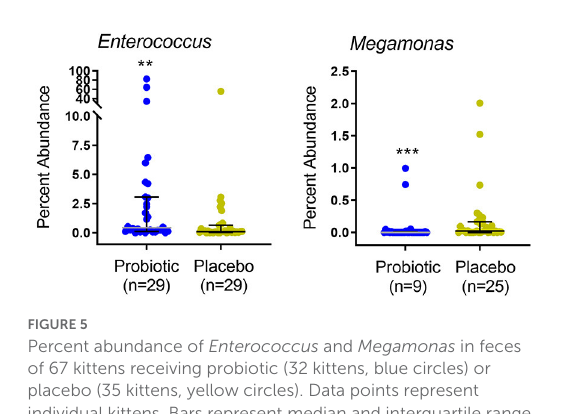
FIGURE5 Percent abundance of Enterococcus and Megamonas in feces of 67 kittens receiving probiotic (32 kittens, blue circles) or placebo (35 kittens, yellow circles). Data points represent individual kittens. Bars represent median and interquartile range. n = number of kittens having the OTU at an abundance > 0. Kruskal-Wallis ANOVA ** p = 0.005 (BH-corrected p = 0.24). *** p < 0.001 (BH-corrected p < 0.09). BH,